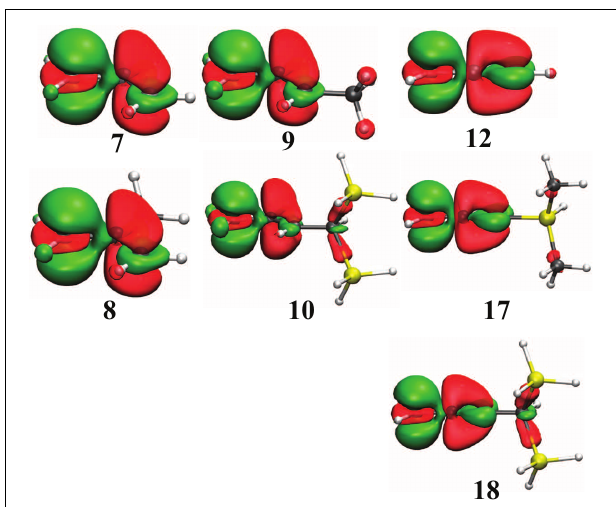
Calculations are at the same level as in Table 2 . a (cid:2) d = d CC + (deloc)–d CC + (loc). b TMS = − Si(Me) 3 . c